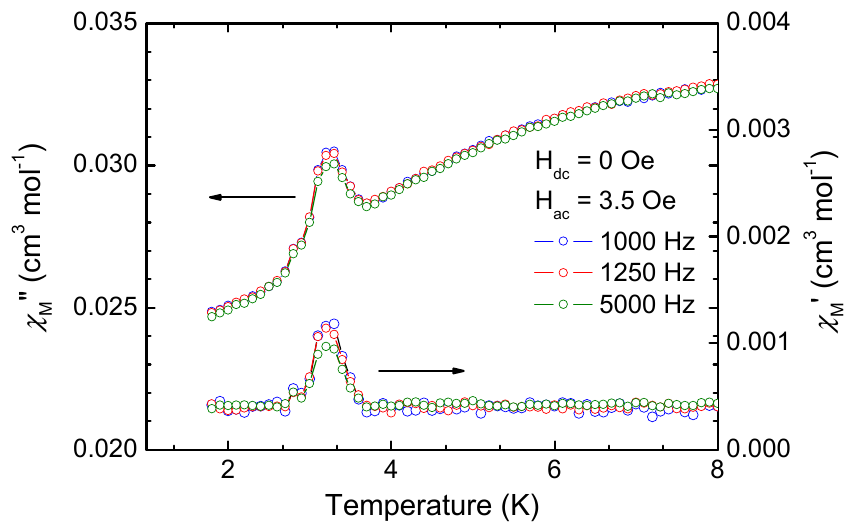
Figure 8. In phase ( χ ′ ) and out-off phase ( χ ′′ ) of the ac magnetic susceptibilities in a zero applied direct current (DC) field and a 3.5 G alternating current (AC) field at the indicated frequencies for compound 1 .